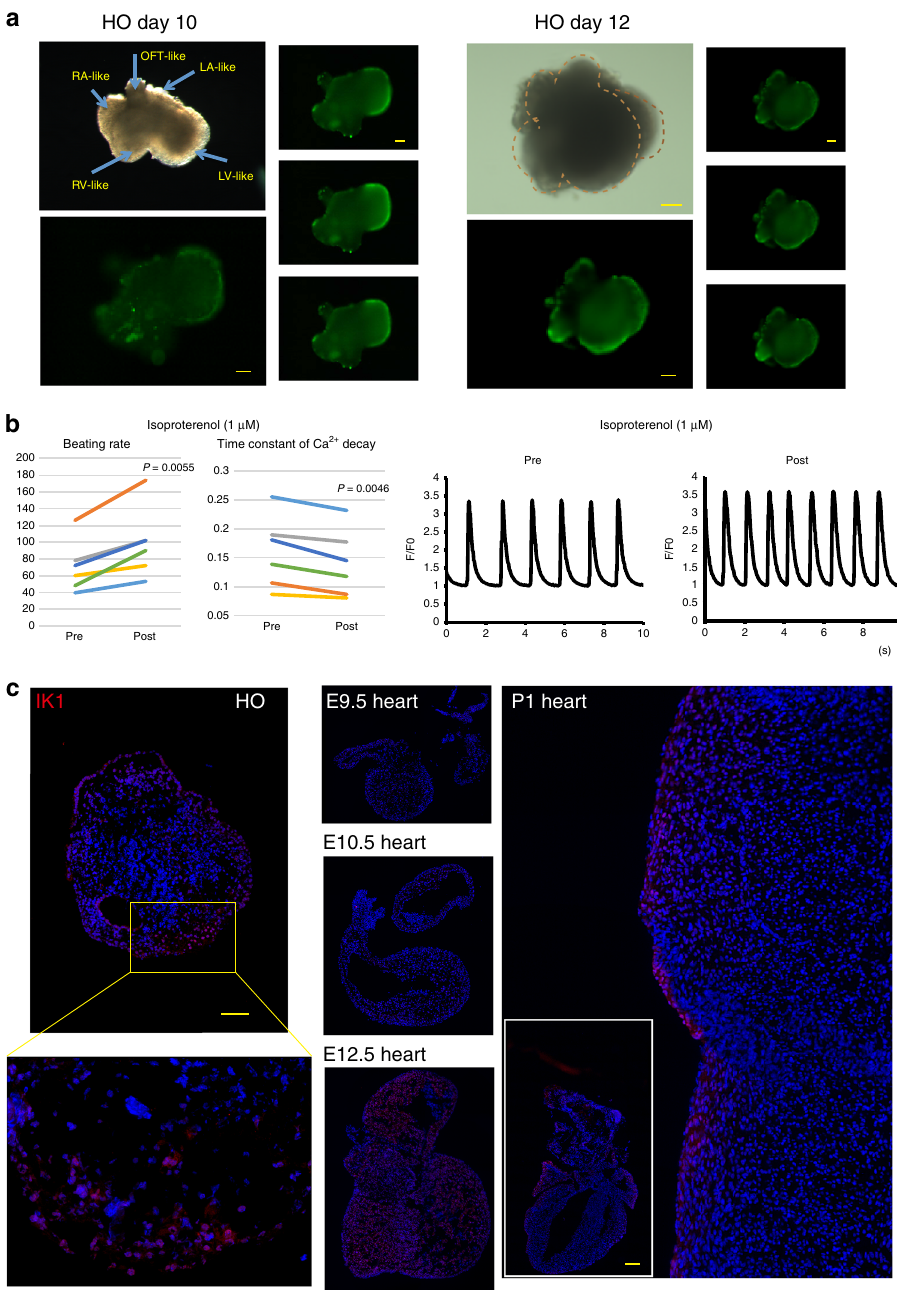
Fig. 9 Functional maturity of heart organoid (HO)s. a Ca 2 + transients in the HOs. Ca 2 + oscillations were analyzed using the Ca 2 + -binding fl uorescent dyes Fluo8 AM. Representative images of HOs ( n = 7, two experiments, each top left panels, bright fi eld and bottom left panels: fl uorescent images). Three fl uorescent images were extracted from every ten frames of sequential images (each right column, see also Supplementary Fig. 7). Scale bar: 100 μ m. b Ca 2 + transients in the 11-day cultured HOs, pre- and post administration of the β adrenergic agonist isoproterenol (1 μ M). Beating rate was increased and time constant of Ca 2 + decay was decreased after treatment of isoproterenol (left, n = 6, P = 0.0055 and 0.0046 by two-sided paired t test). The representative traces of changed Ca 2 + signal (F/F0) before and after the treatment of isoproterenol (right). c IK1 immunostaining in a representative HO (left, n = 10 out of n = 12, two independent experiments), embryonic hearts (E9.5, E10.5 and E12.5; middle) and a postnatal day 1 (P1) mouse heart (right). Inset indicates the whole image of P1 mouse heart. Scale bar: 100 μ m (HO), and 1 mm (P1 mouse